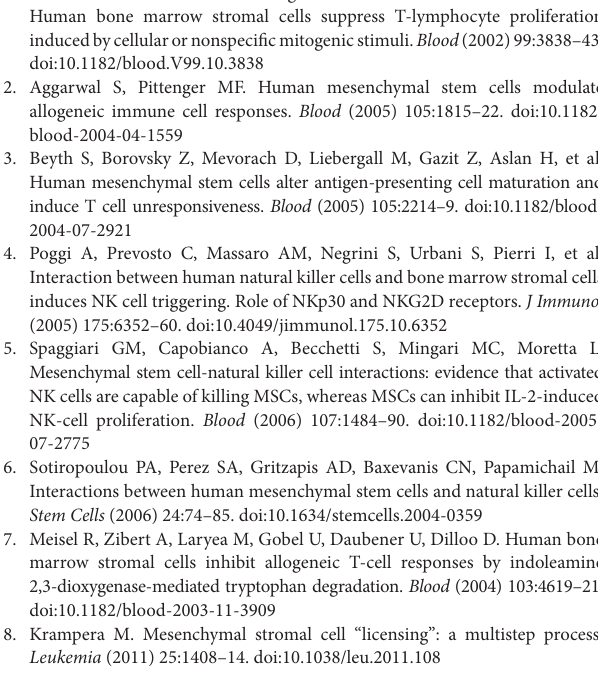
second reagent alone (negative control, white histogram). In each subpanel, the percentage of positive cells, above the bar set on the negative control, and the mean fluorescence intensity (MFI, below the bar) are indicated. Results are shown as Log far-red fluorescence intensity (arbitrary units, a.u.) vs cell number. (c,D) Results are expressed as percentage of positive cells and are the mean with boxes and whiskers min to max of six independent experiments with matched TAF (white boxes) and FB (gray boxes) from six different patients. FigUre s2 | Expression of intercellular adhesion molecule (ICAM)1, NKG2D ligands (NKG2D-L) or DNAM1 ligands (DNAM1-L) on CRC cell lines. The carcinoma cell lines Caco2, HT29, HCT15, SW480, DLD1, HCT116, LS180 (a) , WiDr, LoVo, Colo205, Colo320 DMF, SW620, T84, and SW480 (B) were analyzed for the expression of ICAM1, with the specific monoclonal antibodies, or NKG2D-L or DNAM1-L with the Fc-NKG2D or Fc-DNAM1 chimeric molecules by immunofluorescence assay and FACS analysis. In each panel, the negative control (AlexaFluor647 goat anti-mouse for ICAM1 and AlexaFluor647 human antiserum for the chimeras, black histograms) vs positive samples (gray histograms) is shown. Data are expressed as Log far-red fluorescence intensity (arbitrary units, a.u.) vs number of cells. FigUre s3 | Expression of MICA, ULBPs, or poliovirus receptor (PVR) on selected CRC cell lines. The carcinoma cell lines Caco2, HCT15, and SW480 were analyzed for the expression of MICA, ULBP1, ULBP2, ULBP3, and PVR with specific monoclonal antibodies by immunofluorescence assay and FACS analysis. In each panel, the negative control (AlexaFluor647 goat anti-mouse, white histograms) vs positive samples (gray histograms) is shown. Data are expressed as Log far-red fluorescence intensity (arbitrary units, a.u.) vs number of cells. FigUre s4 | Sorting strategy for NKp46 + CD3 − cells from CRC. NKP46 + CD3 − cell sorting from the OMCR16-030 CRC is shown as an example. Representative gating strategy: plots show first the recognition of the population of interest, without doublets, than the target of sorting NKp46 + cells on CD3 − . (a) Gray dots are doublet 1 and 2 events [depicted in panels (B,c) ] excluded on the basis of physical parameters; (D) dark gray dots are cells excluded on the basis of CD3 expression. (e) Gray dots are sorted NKp46 + CD3 − cells. (F) CD16 and NKp46 expression (NKP46 PE-Cy7 vs CD16 Pacific Blue) on CD3 − cells sorted in panel (e)